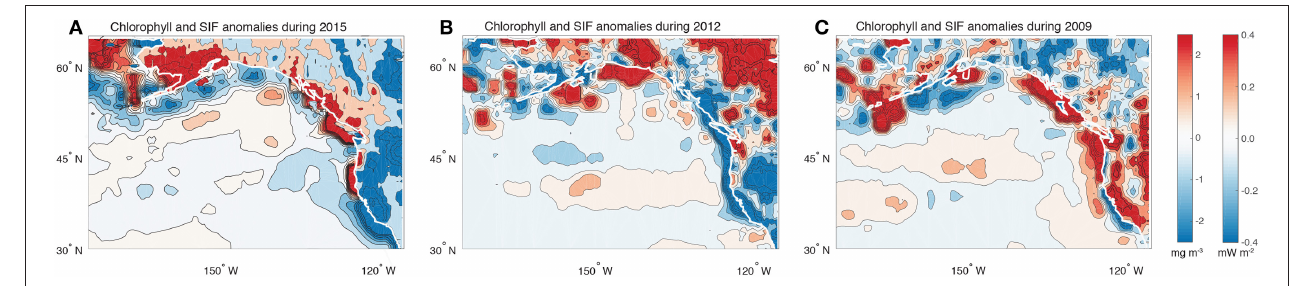
FIGURE 6 | Maps showing the annually-averaged anomalies in SIF and chlorophyll during the 2015 (A) , 2012 (B) , and 2009 (C) calendar years.